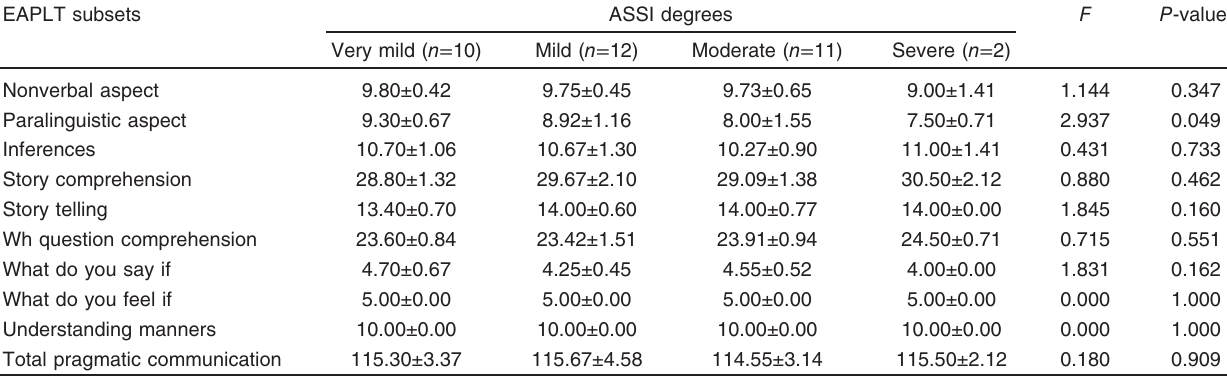
Table 13 Relation between stuttering severity measured by Stuttering Severity Instrument for Children and Adults − Arabic version, and pragmatic language development in children in age group III (8 years 1 month 1 day to 9 years 12 months 31 days) using independent sample analysis of variance test